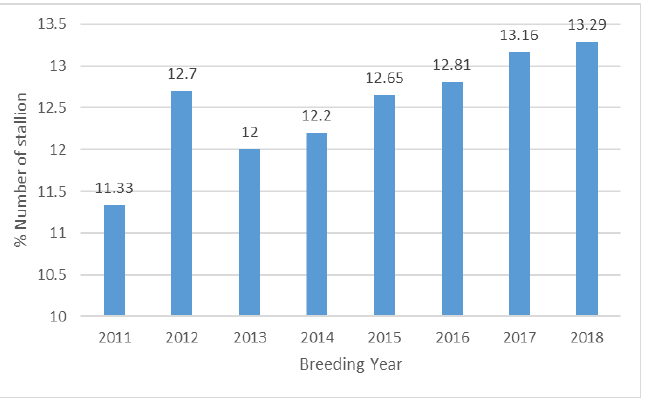
Figure 1. Distribution of stallions according to the breeding years between 2011 and 2018.